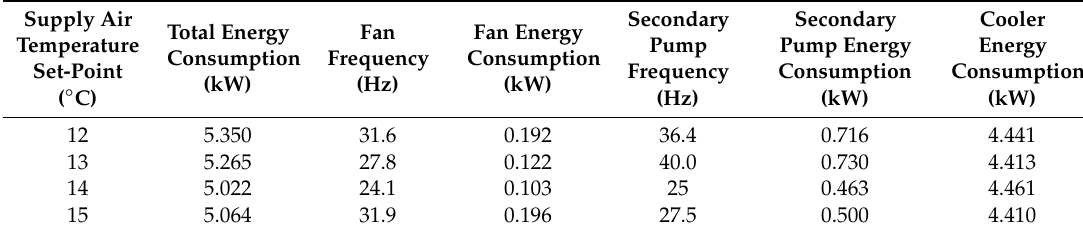
Table 2. System energy consumption changes under di ff erent supply air